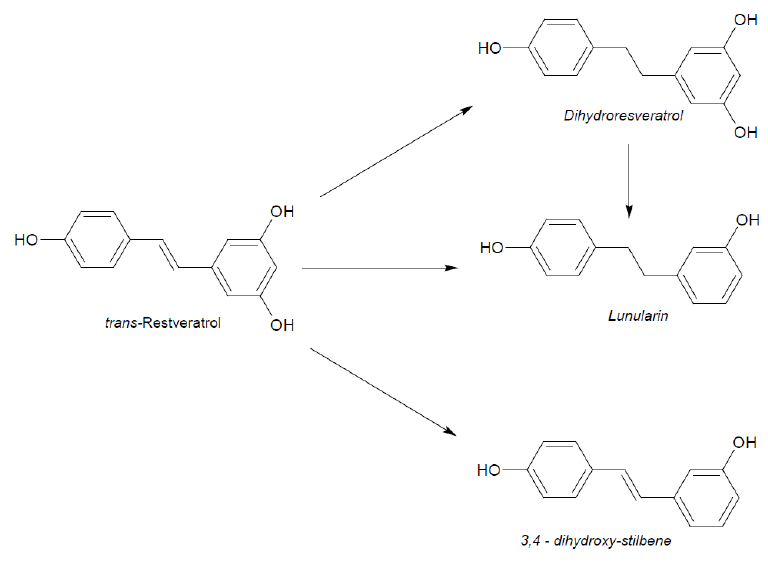
Figure 4. Example of gut microbiota biotransformation of trans -resveratrol.